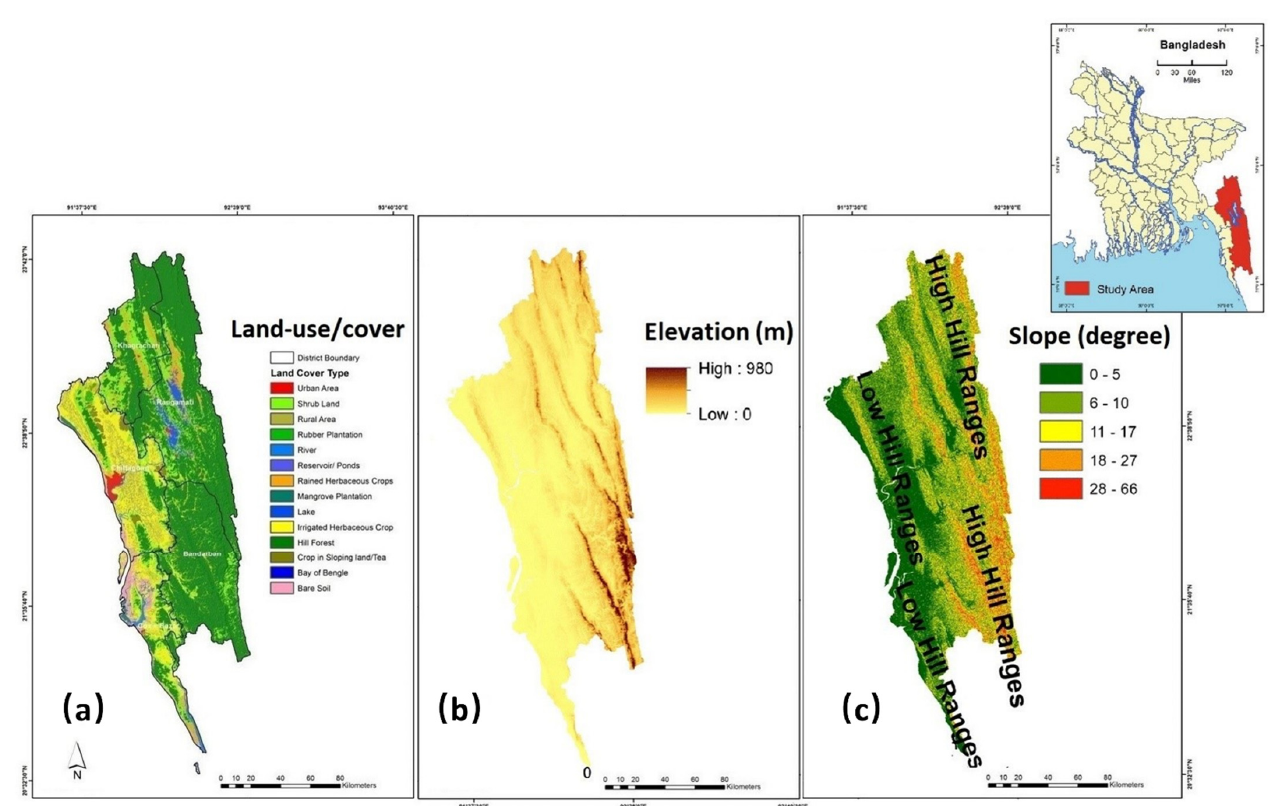
Figure 1. Land use/cover ( a ); ( b ) elevation; and ( c ) slope in the CHT.